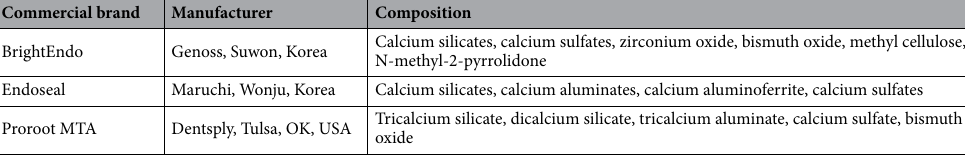
Table 1. Composition of the commercial MTA sealers and the MTA tested in this